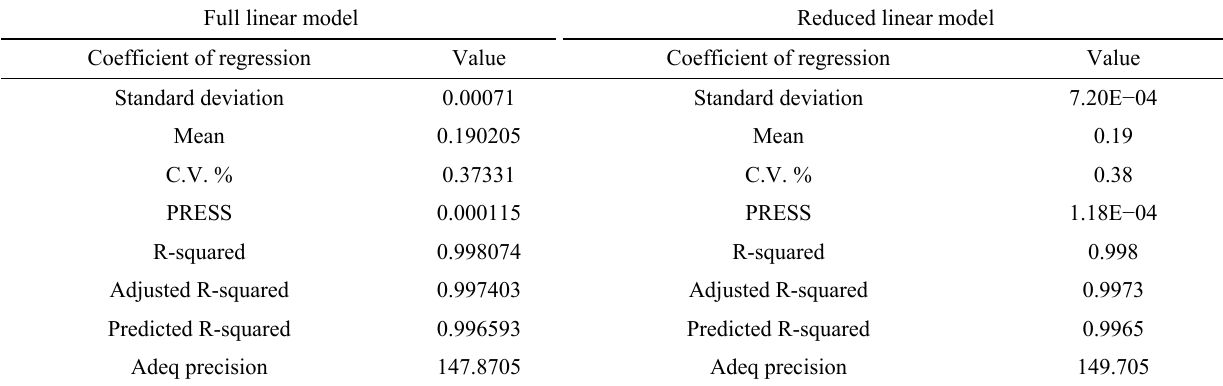
Table 10 Coefficients of regression for the full and modified cubic models from ANOVA